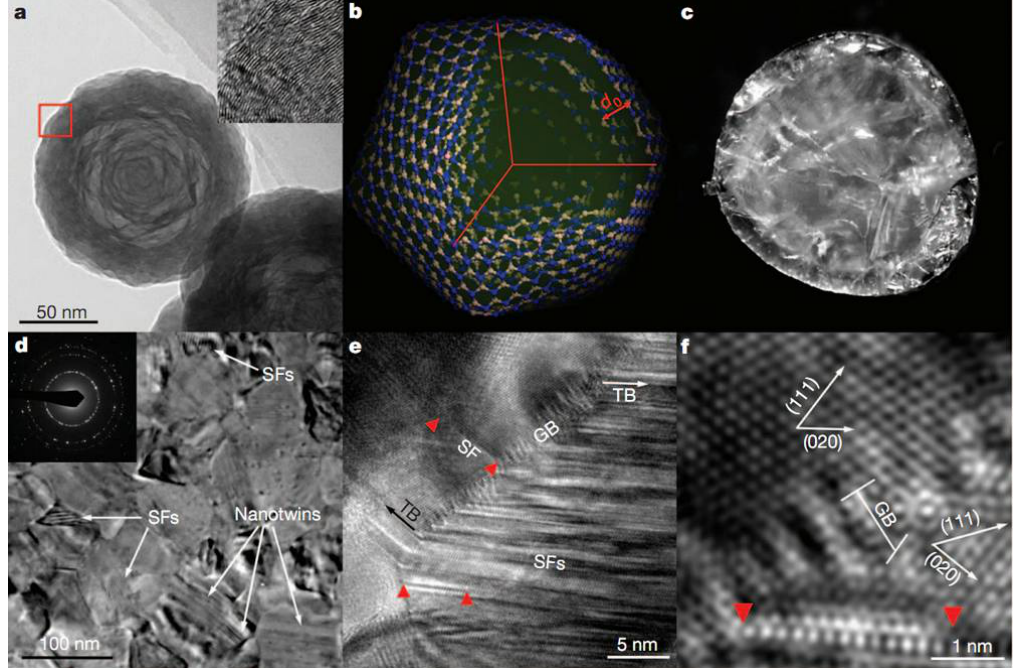
Figure 5. Starting oBN nanoparticles and nt-cBN bulk synthesized at 15 GPa and 1800 ◦ C. ( a ) TEM image of oBN nanopar- ticles. Inset, HRTEM image corresponding to the position marked with the red box, showing defects including lattice puckering, bending, and stacking faults. ( b ) Schematic icosahedral model of a five-shell oBN nanoparticle. d 0 is the inter-shell spacing. ( c ) Photograph of an nt-cBN bulk sample with a diameter of about 2mm. ( d ) TEM image of a typical microstructure in nt-cBN. Nanotwins and stacking faults (SFs) are marked. Inset, a selected area electron diffraction pattern. ( e ) HRTEM image of nt-cBN showing Shockley partial dislocations (red triangles) emitted from grain boundaries (GB) and a high density of stacking faults in twin domains. TB, twin boundary. ( f ), Enlarged HRTEM image of e, showing the orientation relationship between adjacent nanograins. Reprinted with permission from Tian et al., Nature 493, 385 (2013). Copyright 2013 Nature Publishing Group (Ref.